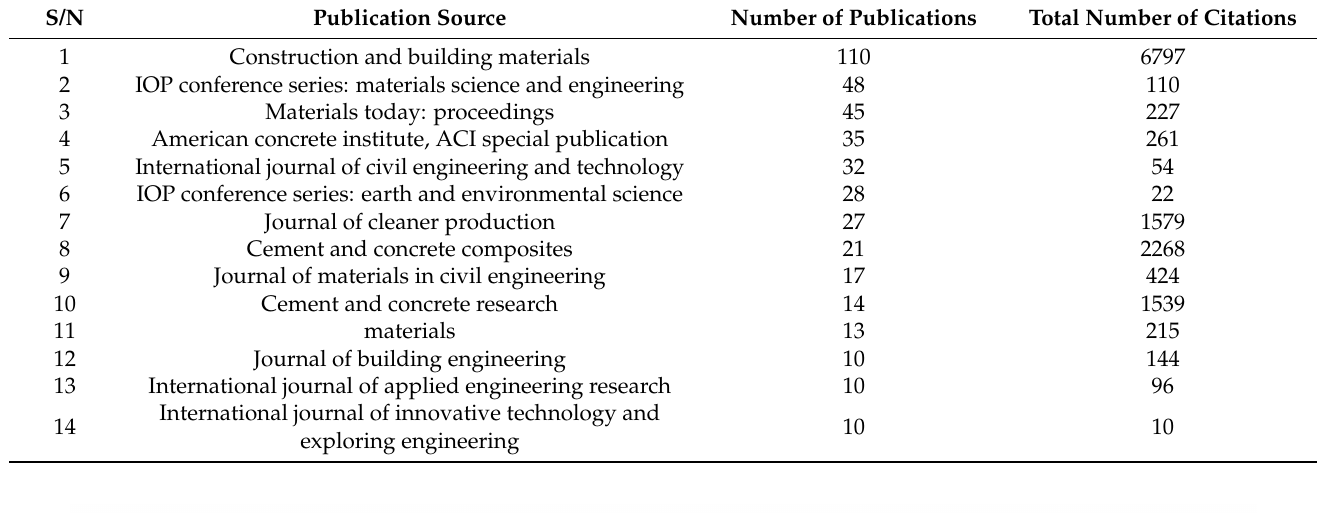
Table 1. Publication sources with at least ten publications in the related research field up to 2021.